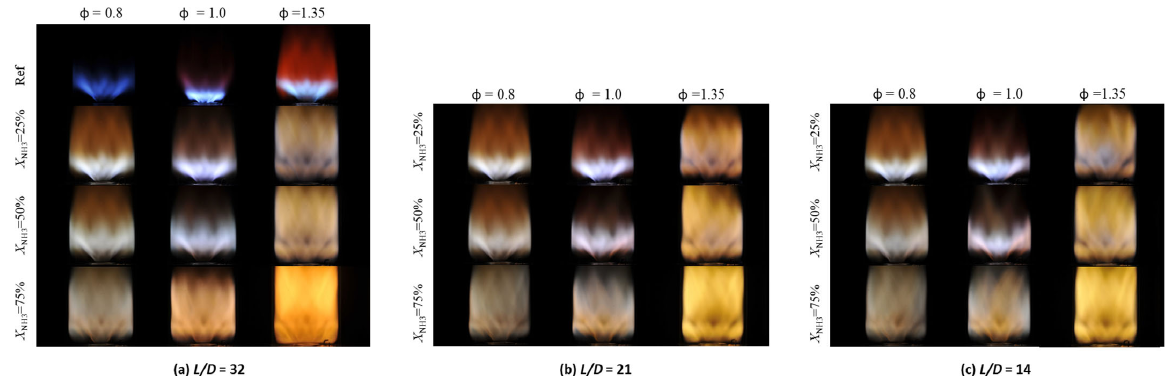
Figure 3. Time ‐ averaged broadband flame images for the three tested mixing length ratios, ( a ) L / D = 32, ( b ) L / D = 21, ( c ) L / D = 14, and at different ammonia volume fractions and equivalence ratios.